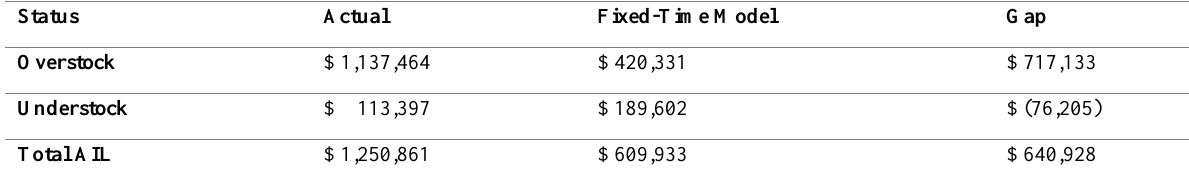
Table 5: AIL Value of